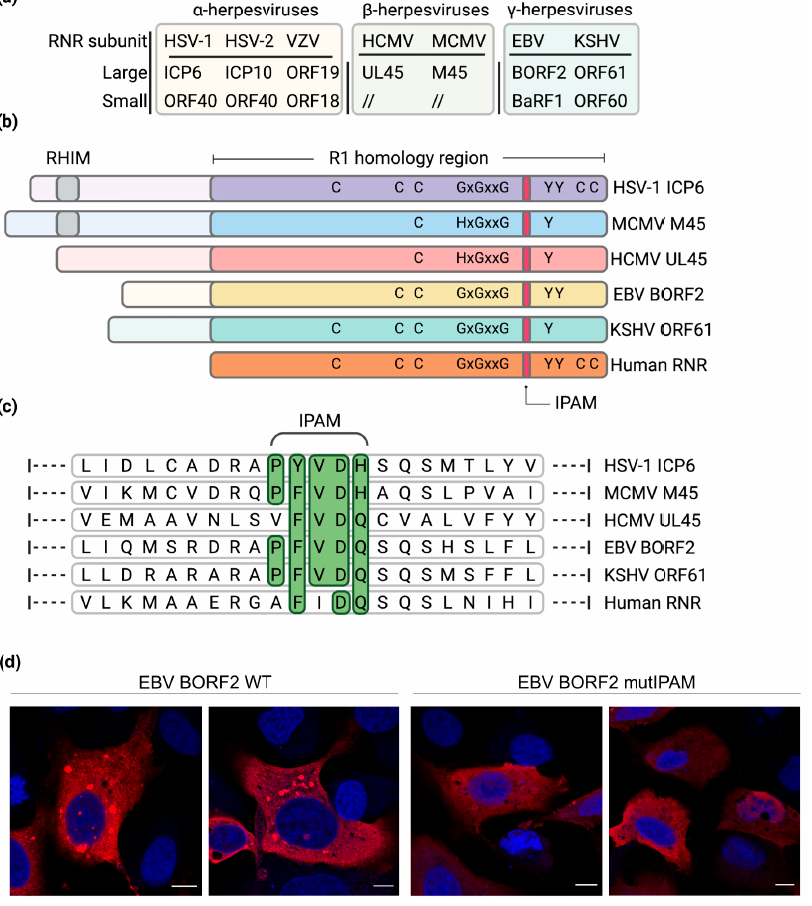
Figure 2. Ribonucleotide reductase in herpesviruses. ( a ) Names of the large (R1) and small (R2) RNR subunit homologs present in alphaherpesviruses, betaherpesviruses, and gammaherpesviruses. ( b ) Schematic representation of human and viral R1 proteins. Residues important for RNR activity are shown. M45 and ICP6 contain a RHIM domain, which is not present in the other viral R1 proteins. ( c ) Alignment of the Induced Protein Aggregation Motif (IPAM). Residues corresponding to the consensus shaded green. ( d ) Requirement of the EBV BORF2 IPAM for the formation of cytoplasmic protein condensates. U2OS cells were transfected with plasmids encoding Flag-tagged wildtype BORF2 or an IPAM mutant. Flag-tagged proteins (red) were detected by indirect immunofluorescence staining and confocal microscopy. Nuclei were counterstained with DAPI (blue). Scale bar, 10 µ m. Panels a, b, and c were made with BioRender.com (accessed on 3 August